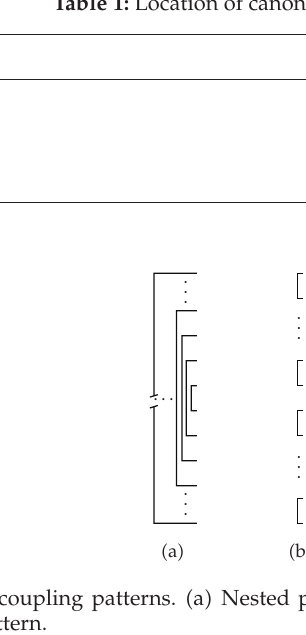
Table 1: Location of canonical nonspiral medallions.